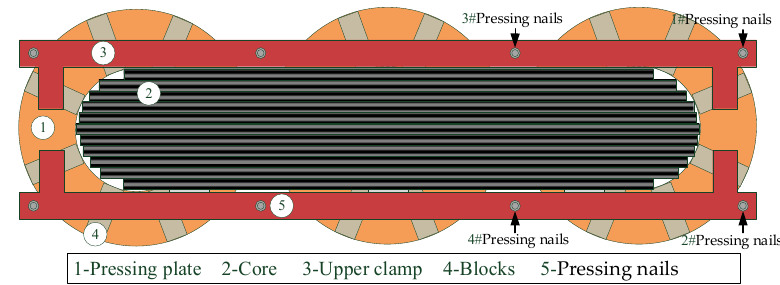
Figure 9. Loosening arrangement diagram of oil-immersed transformer winding. Table 2. Looseness test scheme of winding.